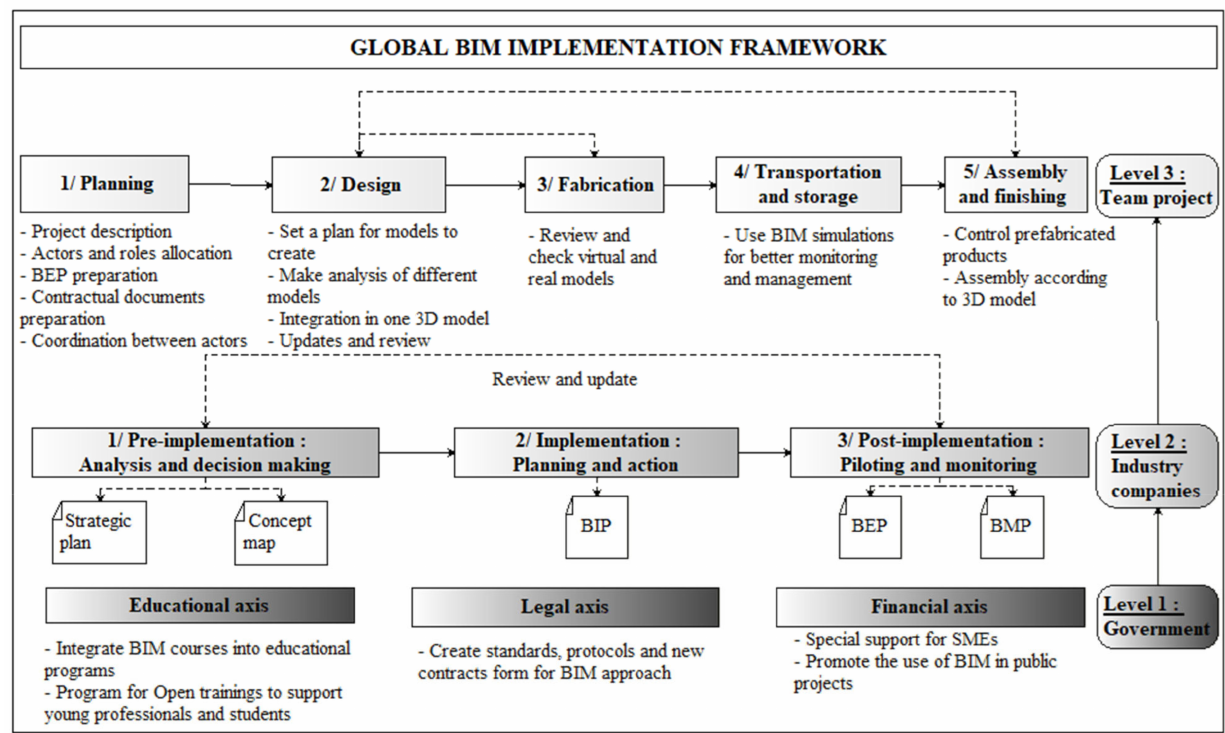
Figure 3. Global BIM implementation